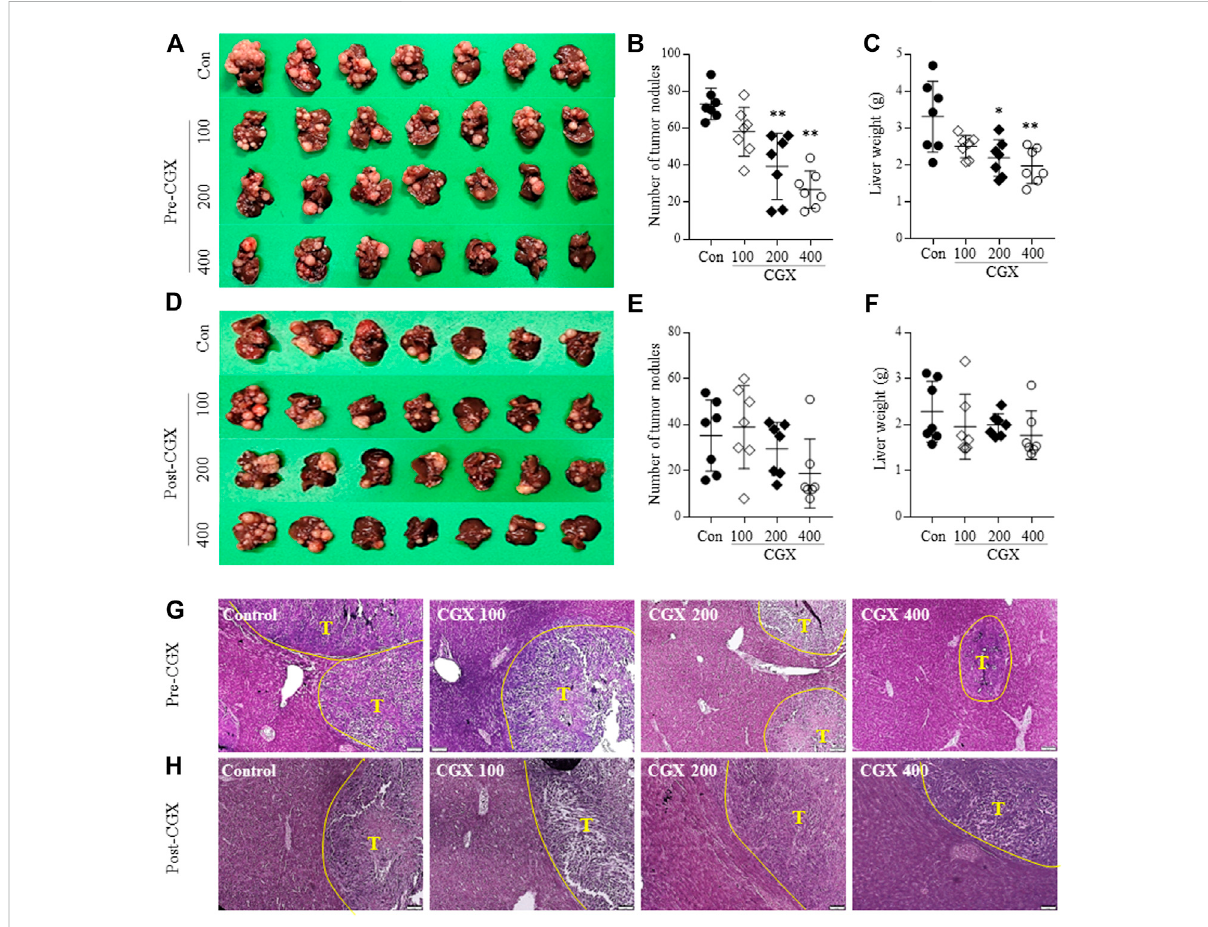
FIGURE 2 Anti-metastaticeffectsofpre-andpostadministrationofCGX.Miceweregivenpre- (A – C) and (G) orpostadministered (D – F) CGX(100,200or 400 mg/kg, 14 days) via MC38-splenic injection. After 21 days of MC38-splenic injection (1 × 10 5 /mouse), the numbers of tumor nodules and liver weight were measured. H&E staining was performed in liver tissue and visualized at ×100 magni fi cations (G – H) . The data are expressed as the means ± SD ( n = 7). * p < 0.05 or ** p < 0.01 indicates statistical signi fi cance compared to the control group. T; Tumor